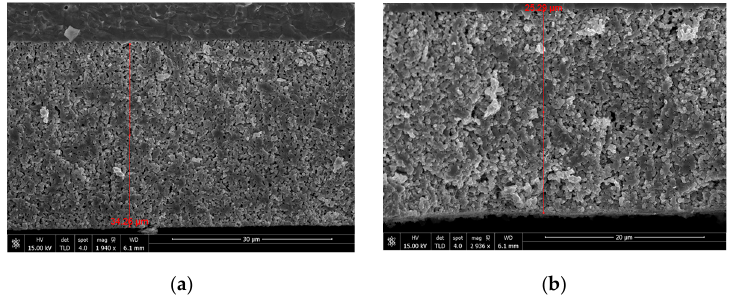
Figure 4. CGO ink distribution within LSCF porous scaffold for drop velocity of ( a ) 2.3 m·s -1 and ( b )